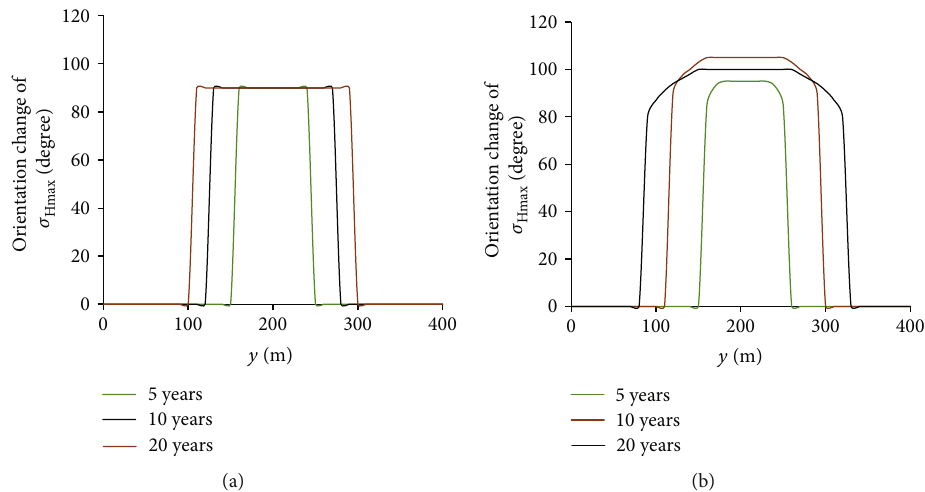
Figure 14: (a) and (b) present the steering angle of the maximum horizontal principal stress along Path B without and with considering the in fl uence of natural fractures in di ff erent production years, respectively.